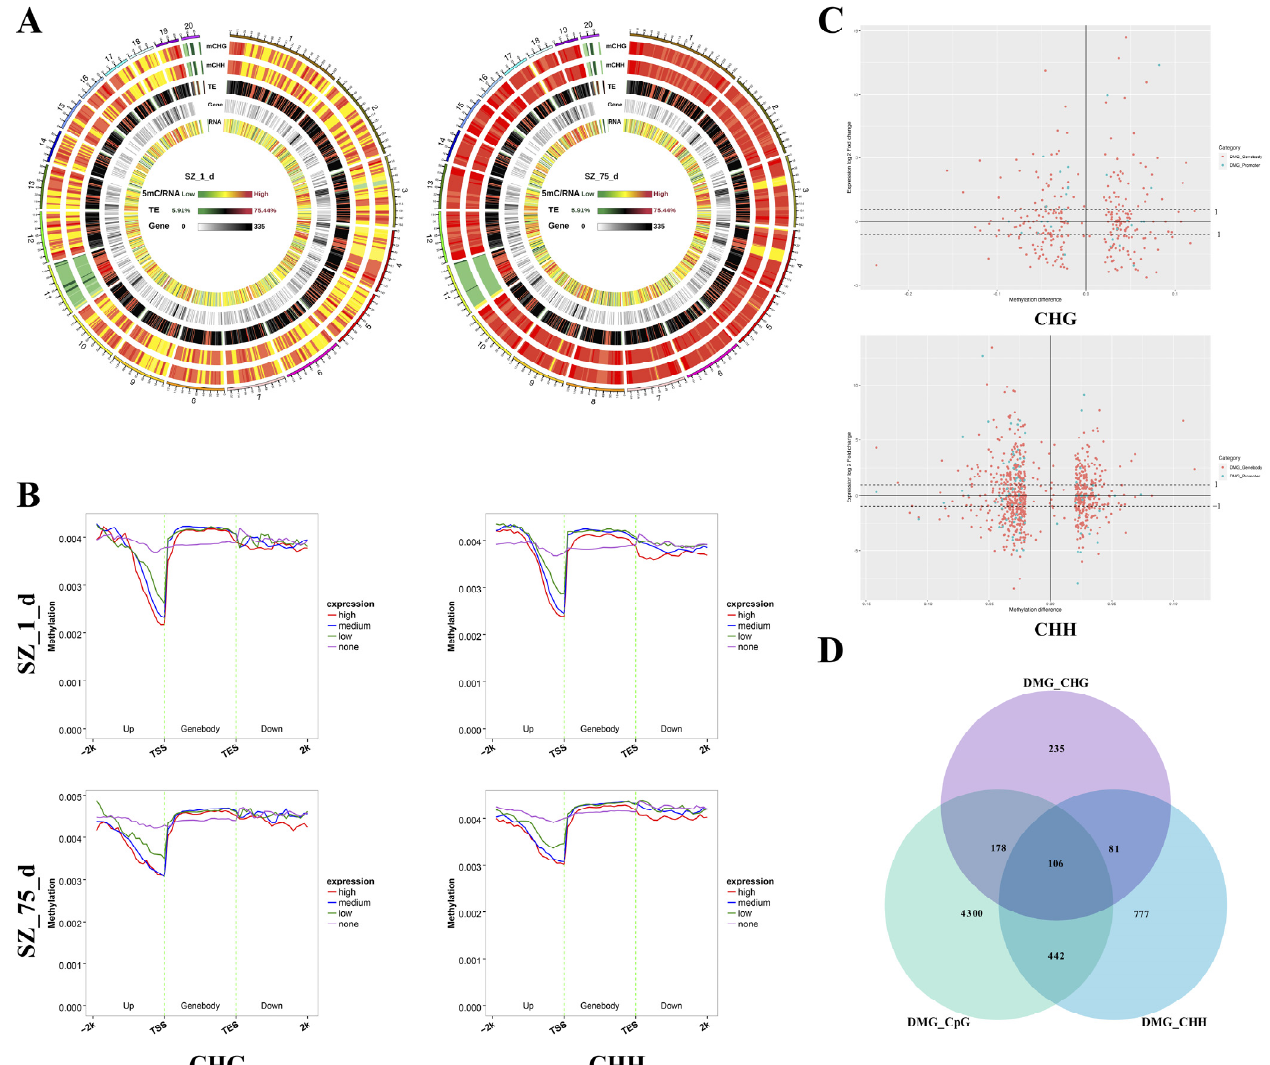
Figure 2. Relationship between non-CpG methylation and gene expression. ( A ) DNA methylation features of two developmental stages at the chromosome level. The outer ring represents the chromosome of the reference genome, and the chromosome information corresponding to the number listed in Supplementary Table S7. mCHG—methylation density in the CHG context; mCHH—methylation density in the CHH context. The 5mC corresponding colors represent methylation density: green, low, and red, high. TE—proportion of repetitive sequences: green, low, and red, high. Gene—the density of genes in each bin: white, low, and black, high. ( B ) Average methylation levels of two types of contexts across and around gene bodies of genes with different expression levels, at two developmental stages. Genes were classified into four groups according to their expression level (no expression, low expression, medium expression, and high expression), by RNA- seq. ( C ) Differential methylation levels and corresponding differential expression levels of DMGs in two types of contexts. ( D ) DMGs of three types of